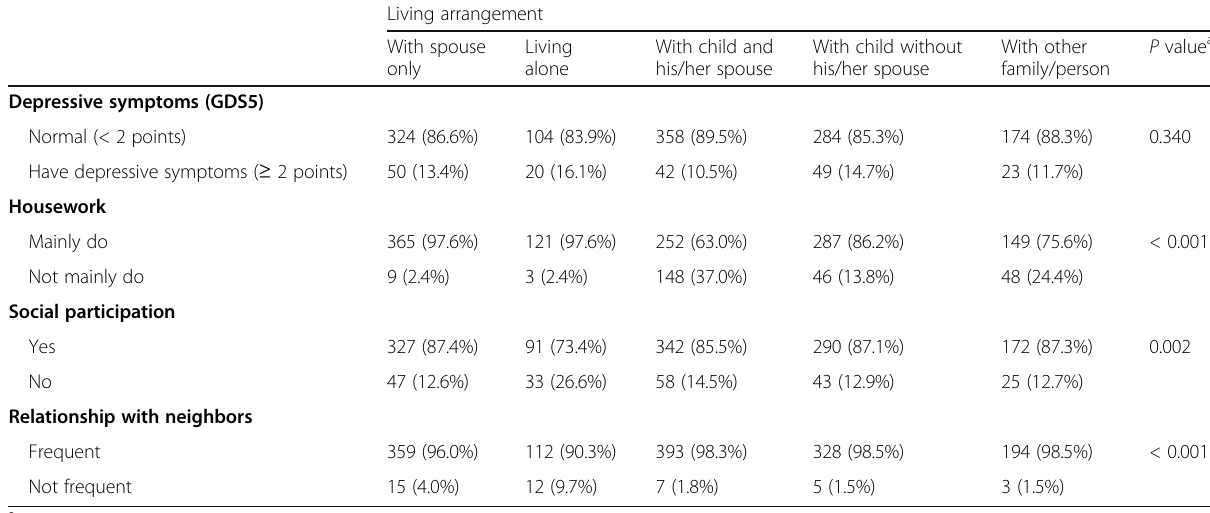
Table 1 Characteristics of the study population at baseline (Continued)